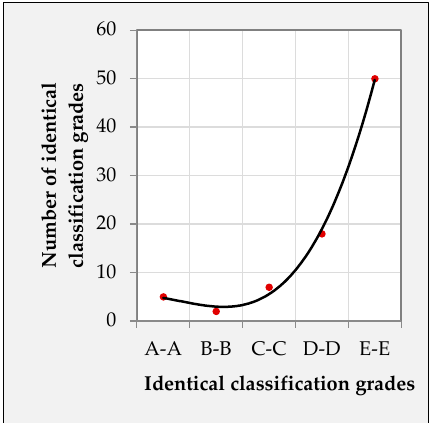
Figure 9. The number of identical overall assessments obtained in the Statistics course and the Mathematics course at each identical classification grade.